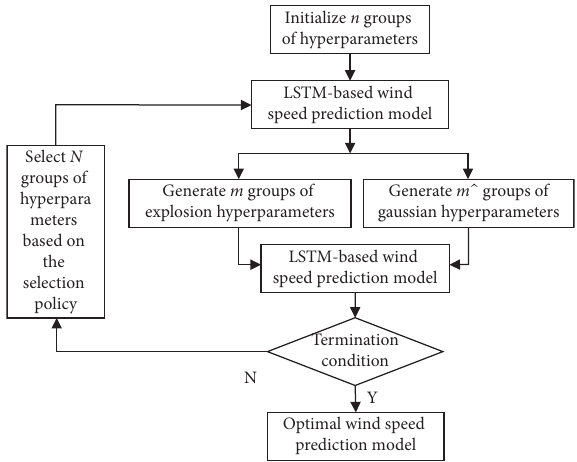
Figure 4: The specific calling relationship between the FWA hyperparameter optimization and the LSTM-based wind speed prediction